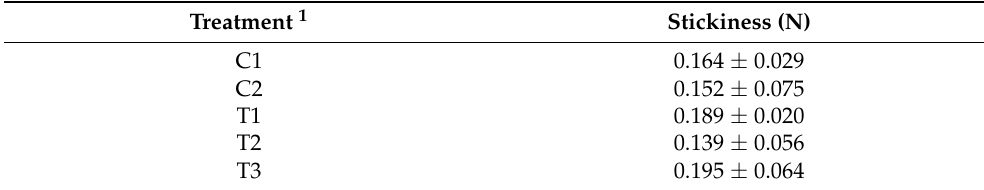
Table 4. Effect of bran incubation and ascorbic acid addition on stickiness of intermediate wheatgrass dough ( n =